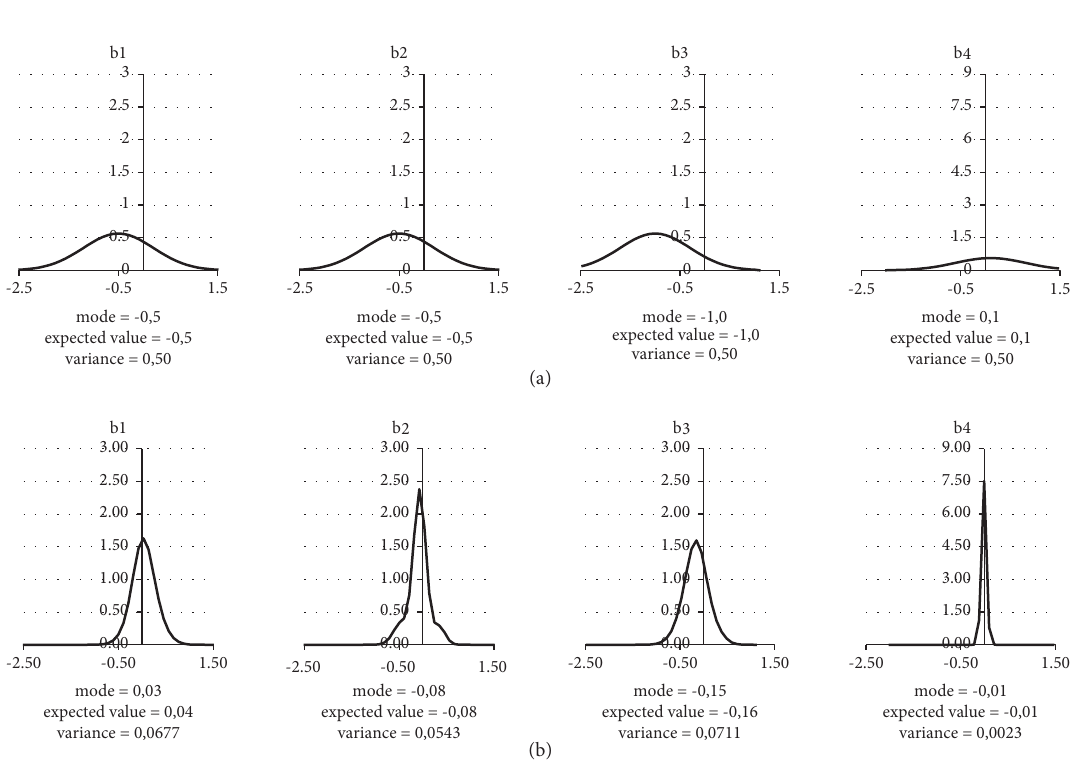
Figure 2: Prior and posterior probability of the parameters b in the numerical example. (a) Prior probability of the parameters b over I adopted in the numerical example. (b) Posterior probability of the parameters b over I and x obtained in the numerical example. Table 1: Sentiment probabilities and observed frequencies evaluation in the numerical example. Sentiment